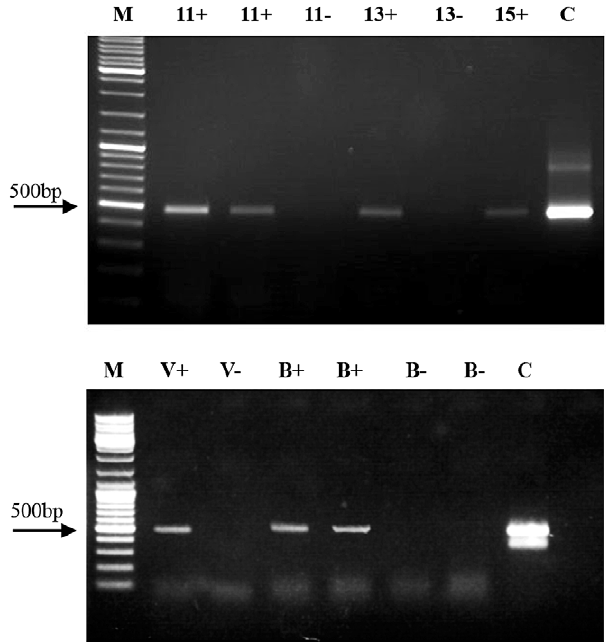
and from Varroa to bee. (A) Indirect dsRNA transmission from bee to Varroa parasitizing bee brood. RT-PCR of Varroa -extracted RNA. Numbers represent days from the beginning of dsRNA feeding. M=size markers. C=positive control (GFP-carrying plasmid). + indicates samples collected from dsRNA-GFP-treated hives. – indicates samples collected from untreated, control hives. (B) DsRNA transmission from Varroa to bee. RT-PCR was performed on RNA extracted from a dsRNA-GFP- carrying Varroa (V + ) and from Varroa devoid of dsRNA-GFP (V 2 ). B + represents amplification of RNA from bees infested with dsRNA-GFP- carrying Varroa and B– represents amplification from bees infested with dsRNA-GFP-devoid Varroa . M and C: as in legend for